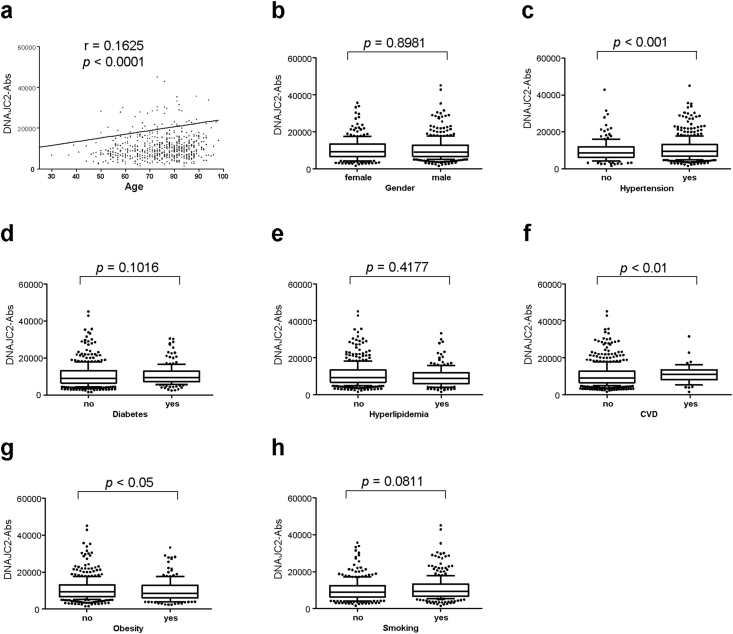
Association between DNAJC2-Ab levels and other clinical parameters in stroke patients. Correlations between DNAJC2-Ab levels and age (a), sex (b), hypertension (c), diabetes mellitus (DM) (d), hyperlipidemia (e), cardiovascular disease (CVD) (f), obesity (body mass index ≥25) (g), and smoking (h) were examined using Spearman's correlation analysis (a) or the Mann–Whitney U test (b–h).